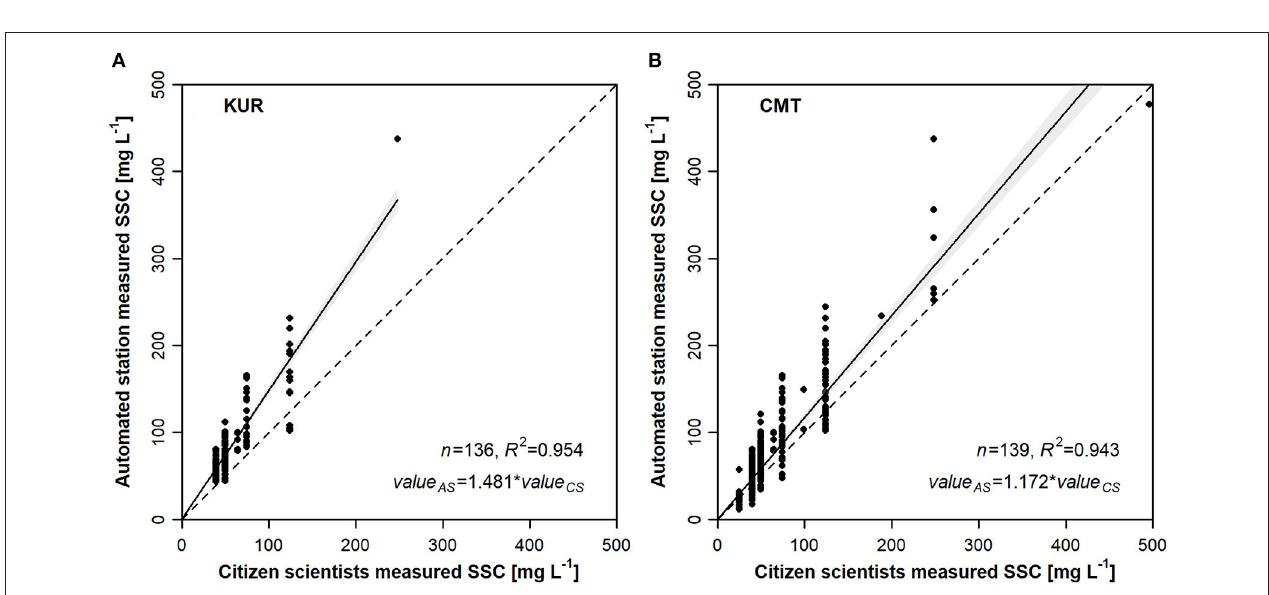
FIGURE 3 | Comparison of the suspended sediment concentration (mg L − 1 ) calculated based on calibrated turbidity measurements collected by citizen scientist and automated stations between September 2017 and September 2019 for (A) KUR and (B) CMT in the Sondu-Miriu river basin, Kenya. The dashed line represents the 1:1